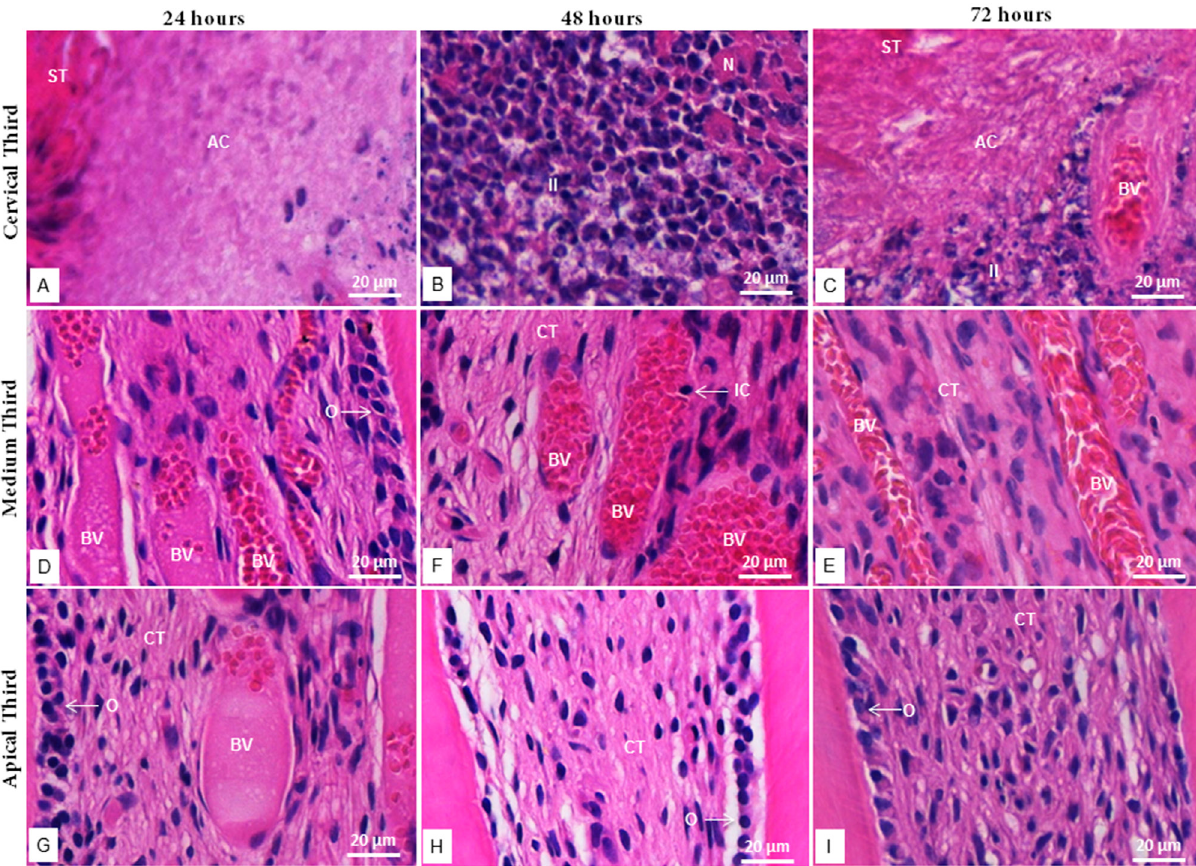
Figure 4- Photomicrographs of hematoxylin and eosin-stained radicular third sections of FS-treated teethat 24, 48 and 72 hours. a-c: Cervical radicular third at 24, 48 and 72 hours, respectively; d-f: Medium radicular third at 24, 48 and 72 hours, respectively; g-i: Apical radicular third at 24, 48 and 72 hours, respectively. (ST) superficial tissue; (AC) acellular layer; (II) inflammatory infiltrate; (N) necrosis; (BV) blood vessels; (CT) connective tissue; (O) odontoblast; (IC) inflammatory cell. 40x